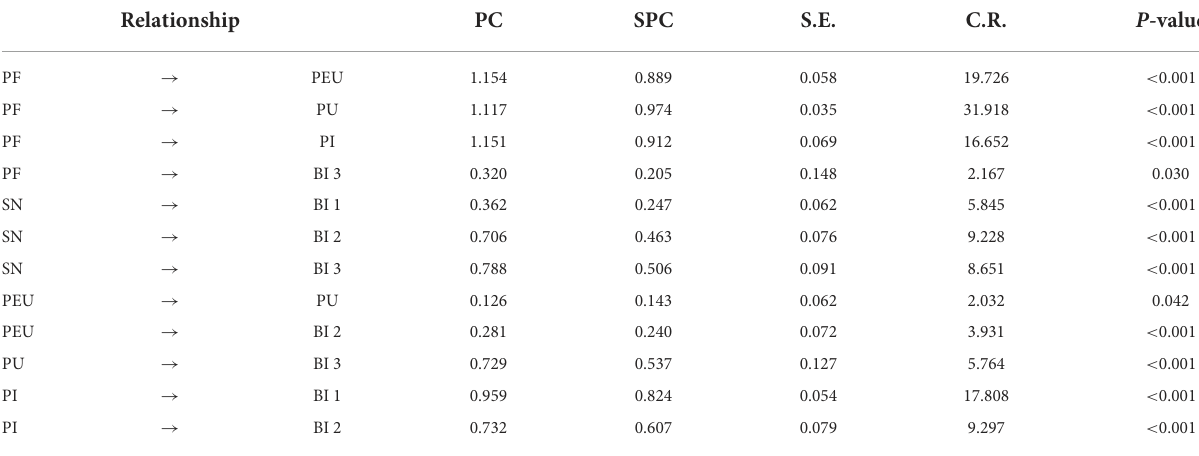
TABLE 3 Model path coefficient